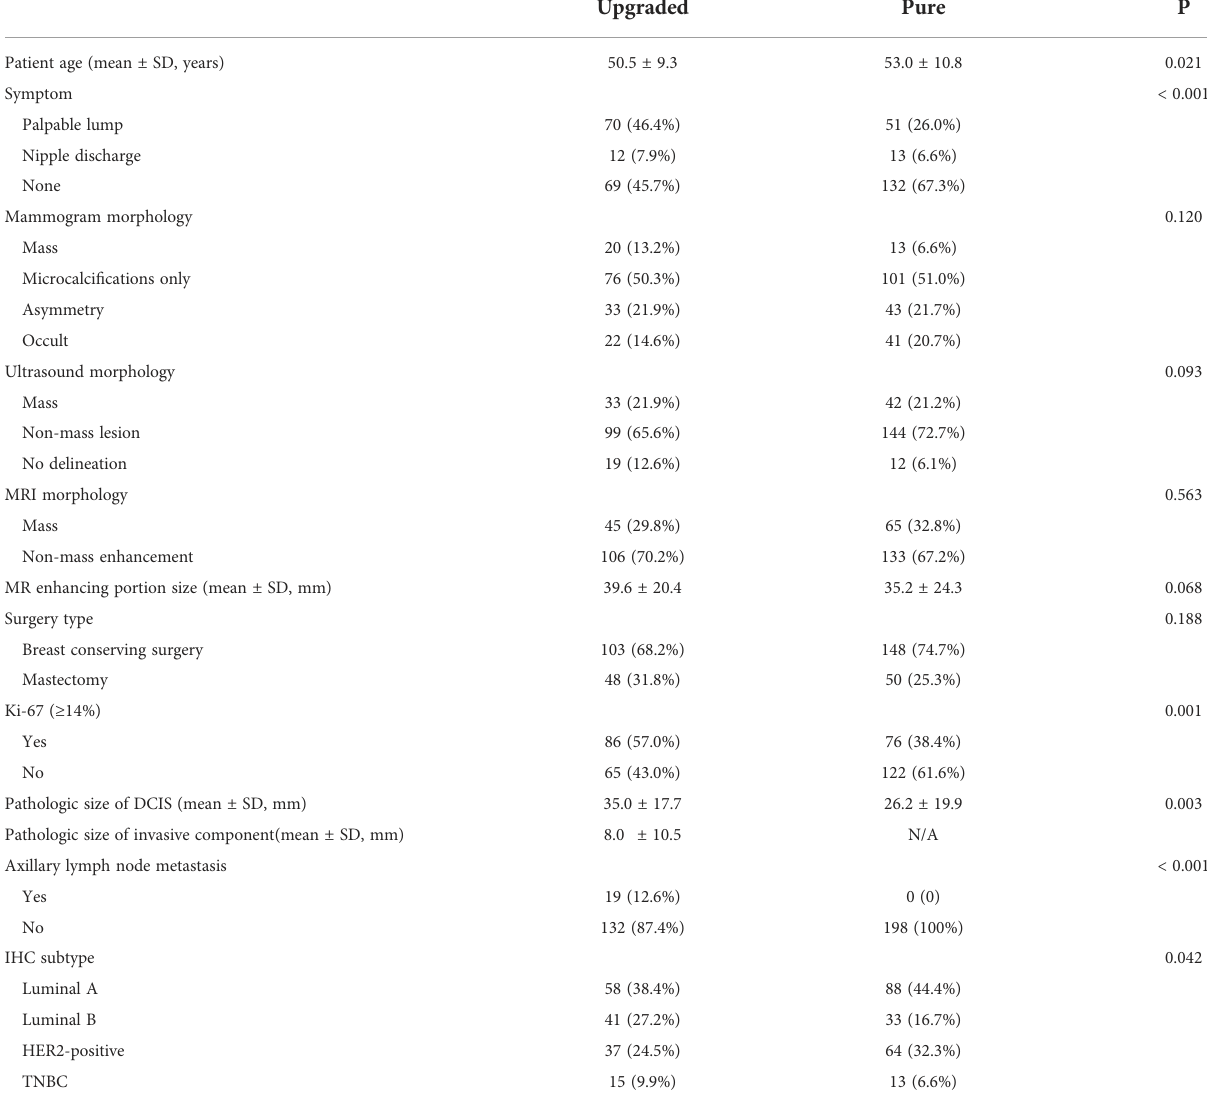
TABLE 2 Comparison of clinicopathologic features between upgraded (n = 151) and pure DCIS (n =